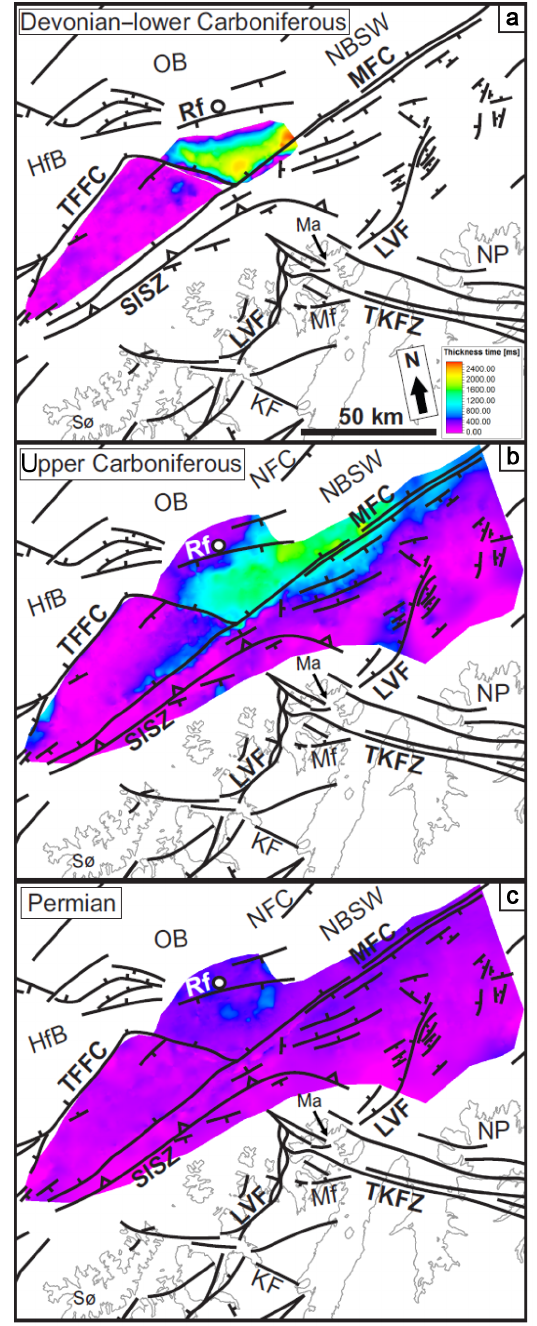
Figure 9. Thickness maps in milliseconds (ms) two-way time (TWT) of late Paleozoic sedimentary successions on the Finnmark Platform and in the southwesternmost Nordkapp basin. Color scale in panel (a) ; (a) thickness map of the Devonian–lower Carboniferous succes- sion on the western Finnmark Platform and in the southwesternmost Nordkapp basin. The succession is thickest in the southwesternmost Nordkapp basin and represents the thickest sedimentary unit of the basin. Note that in this part of the margin, the SISZ and basin-bounding faults were used as base Devonian reflections. On the western Finnmark Platform, lower Carboniferous sedimentary rocks are missing but Devonian sedimentary deposits are possibly preserved in an ENE–WSW-trending graben adjacent to the southwesternmost Nordkapp basin and bounded to the southeast by the MFC; (b) thickness map of the upper Carboniferous sedimentary succession showing gradual thicken- ing of upper Carboniferous sedimentary rocks in the southwesternmost Nordkapp basin, on the western Finnmark Platform in the hanging wall of the MFC, and on the eastern Finnmark Platform in the hanging wall of the LVF and of a SE-dipping fault that parallels the MFC; (c) thickness map of the Permian succession showing very thin Permian sedimentary deposits and very mild thickness variations within the Permian sedimentary succession throughout the study